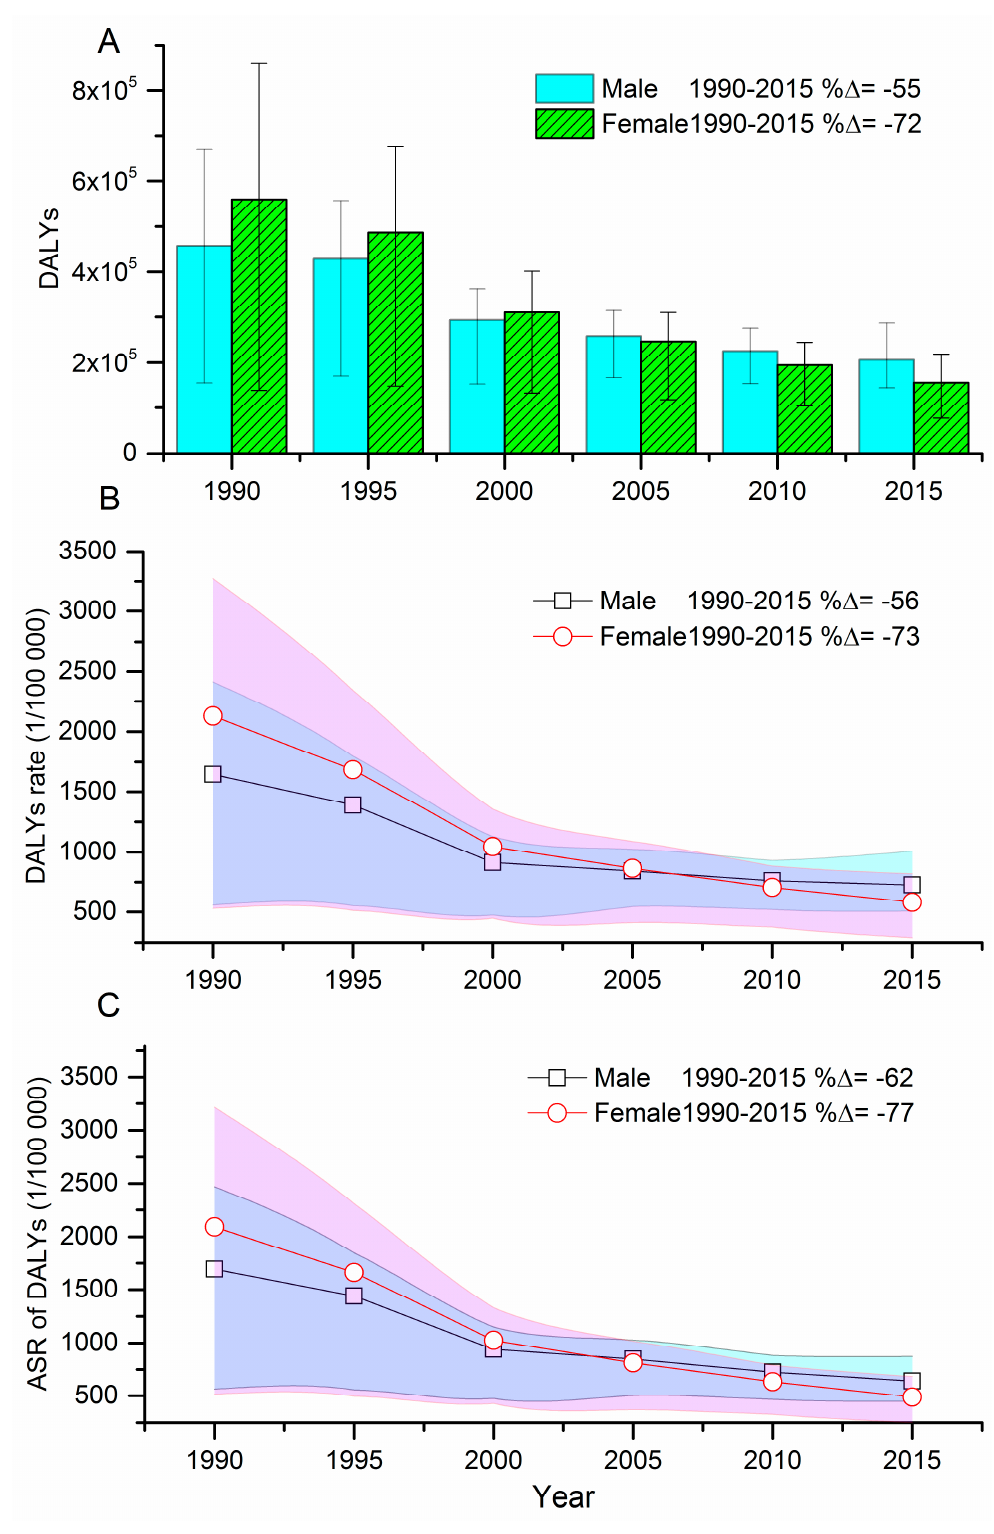
Figure 3. Disability adjusted life-years (DALYs) ( A ), DALYs rate ( B ) and age-standardized DALYs rate ( C ) per 100,000 due to self-harm in Hubei, 1990–2015. (% (cid:52) = percentage change. DALY = disability-adjusted life ‐ years.)